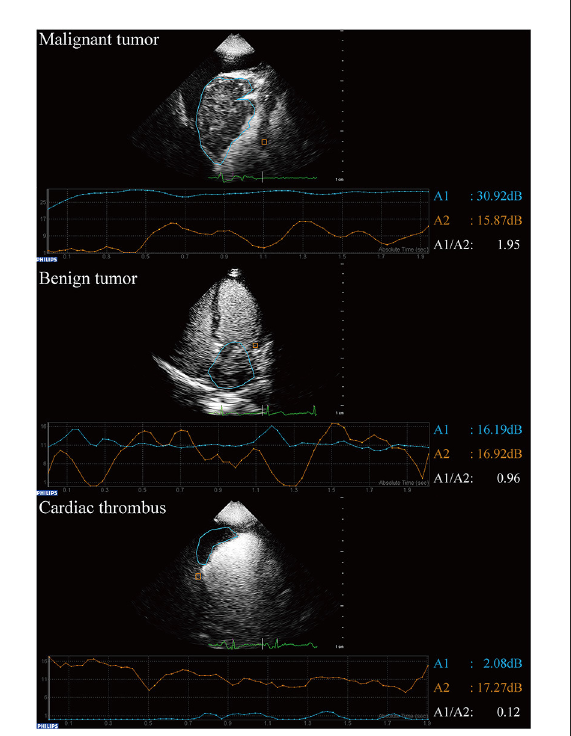
FIGURE1 Qualitative analysis of contrast echocardiography in patients with suspected cardiac masses using QLAB